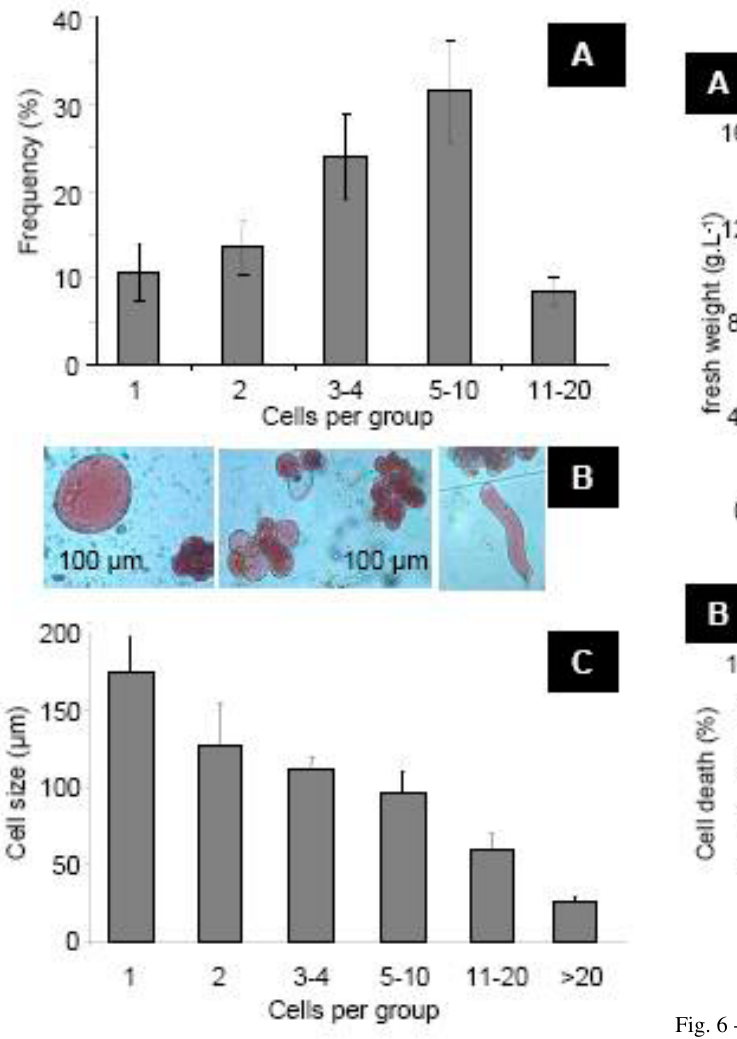
Fig. 4 - Morphology of six-day-old Cakile maritima suspension cells. (A) Frequency of cell groups in the culture. (B) Different mor- phologies of cells. (C) Sizes of the cells according to the size of the cell groups. At least 250 cells were analyzed; bars indicate mean ± SD.